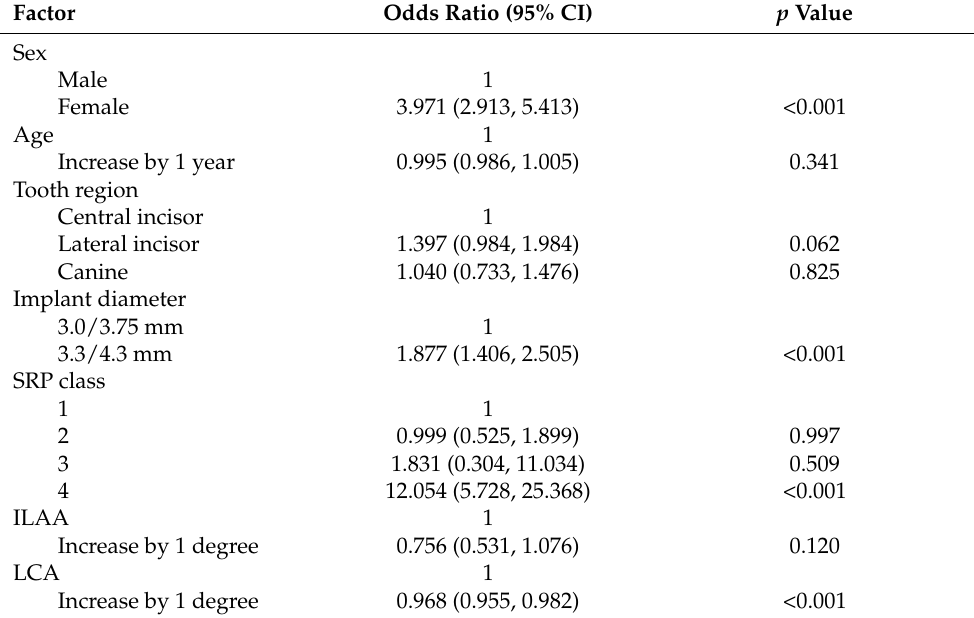
Table 7. Univariate binary logistic regression models for cortical bone perforation or invasion of the 2 mm secure distance from the surrounding anatomical structures (in relation to no perforation), for bone-driven implant position.